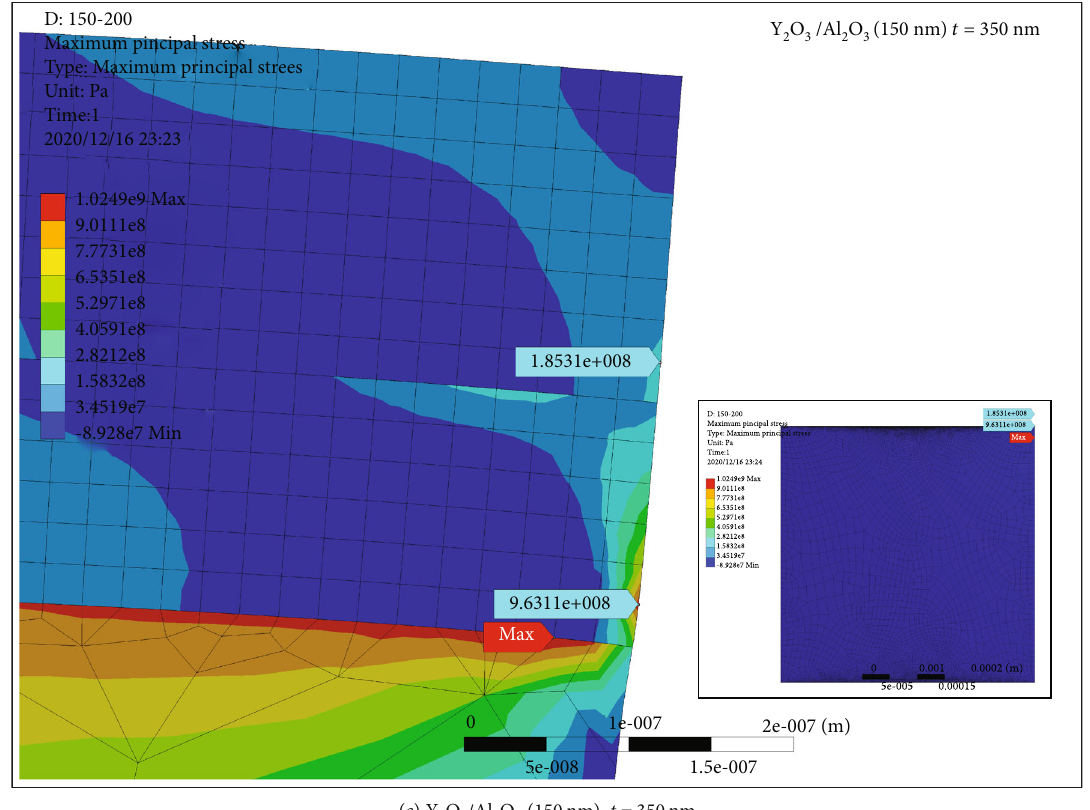
Figure 6: Comparison of the max principal stress in 3 systems of the same individual thickness: (a) max principal stress in Al ( t = 150nm ); (b) max principal stress in Y